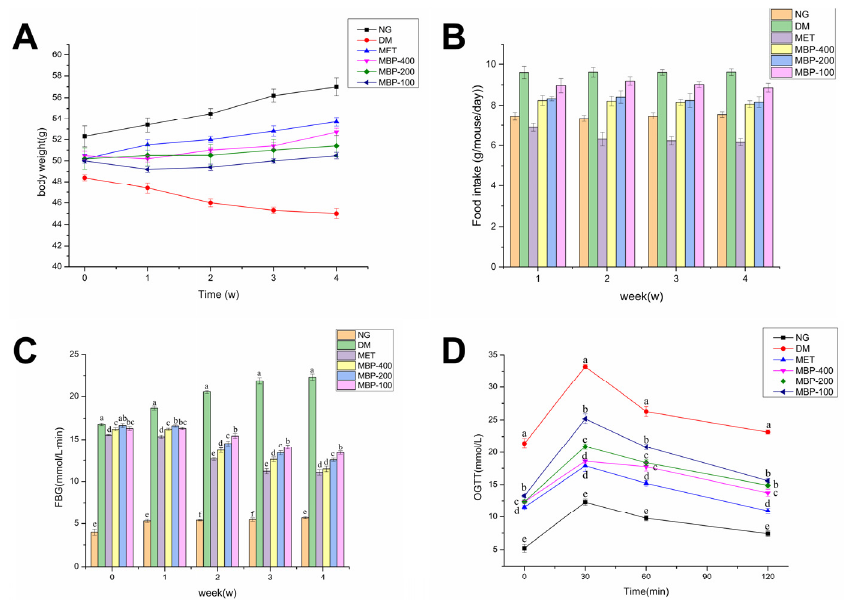
Figure 1. Effects of MBP on body weight ( A ), food intake ( B ), fasting blood glucose (FBG) ( C ), and oral glucose tolerance test (OGTT) ( D ). Different letters are significantly different at p < 0.05 .